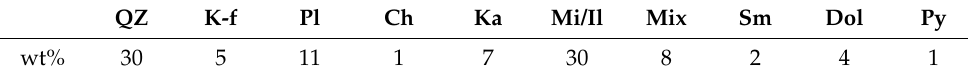
Table 1. Mineralogical composition of Pierre shale estimated based on X-ray diffraction. QZ K-f Pl Ch Ka Mi/Il Mix Sm Dol Py wt% 30 5 11 1 7 30 8 2 4